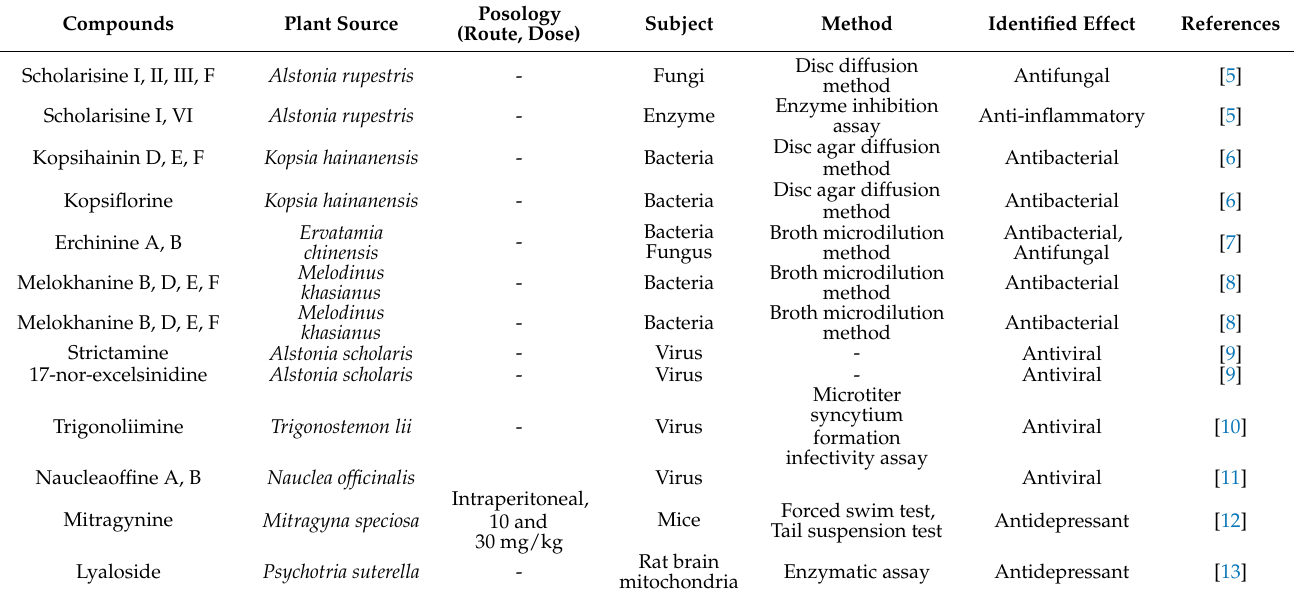
Figure 18. Antimycobacterial activity of indole alkaloids. Table 1. Plant source and pharmacological activity of indole